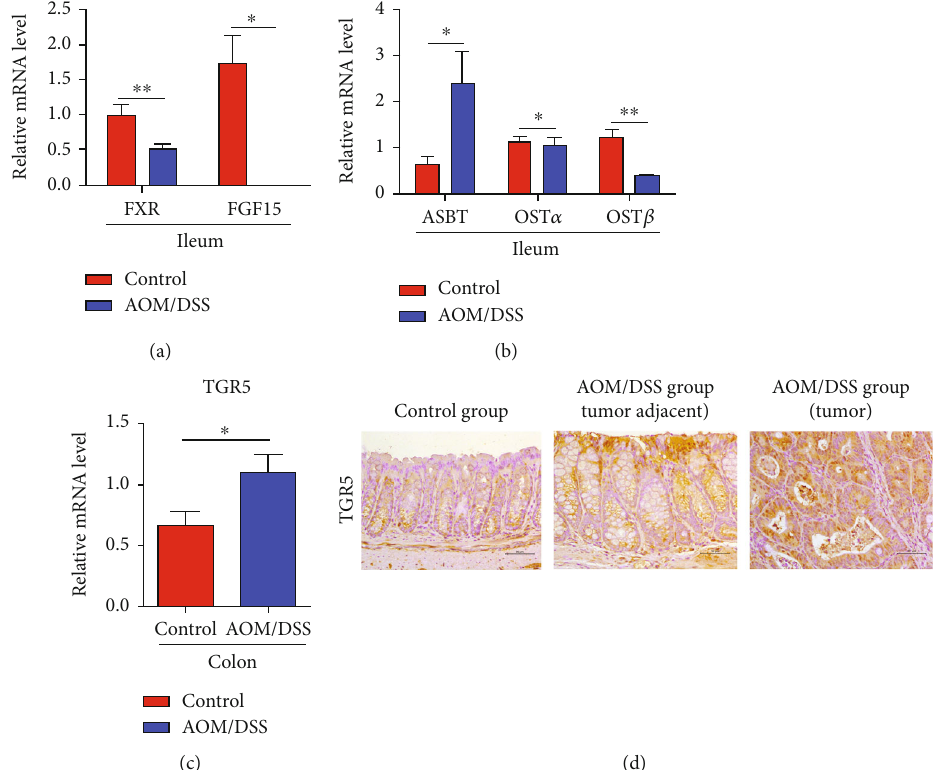
Figure 6: The expression of bile acid receptors in the colitis-associated cancer model. (a) The mRNA expression of ileum FXR and FGF15 was reduced in the AOM/DSS group. (b) Real-time PCR showed an increased expression of ASBT and a decreased level of OST α and OST β in the ileum of the AOM/DSS group. (c) The mRNA expression of colon TGR5 was elevated in the tumor of the AOM/DSS group by Real-time PCR. (d) Immunohistochemical staining showed higher expression of TGR5 in mice with AOM/DSS treatment than in the control group. ASBT: apical sodium-dependent bile acid transporter. OST α and OST β : organic solute transporter subunit α and β . Scale bars: 50 μ m. ∗ p < 0 : 05 , ∗∗ p < 0 : 01 . n = 8